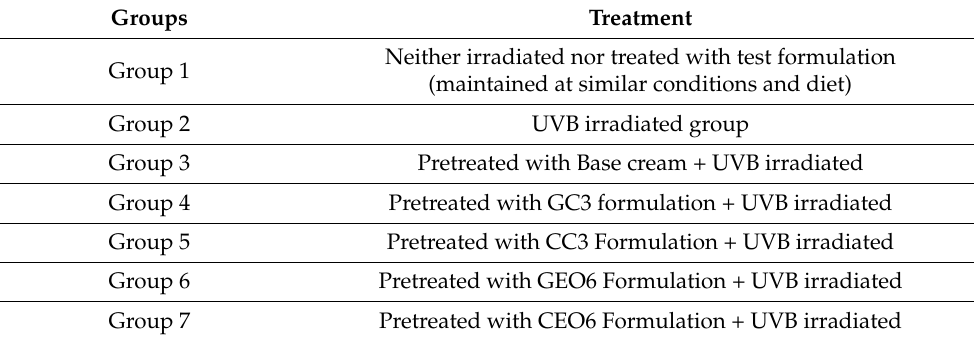
Table 2. Grouping of